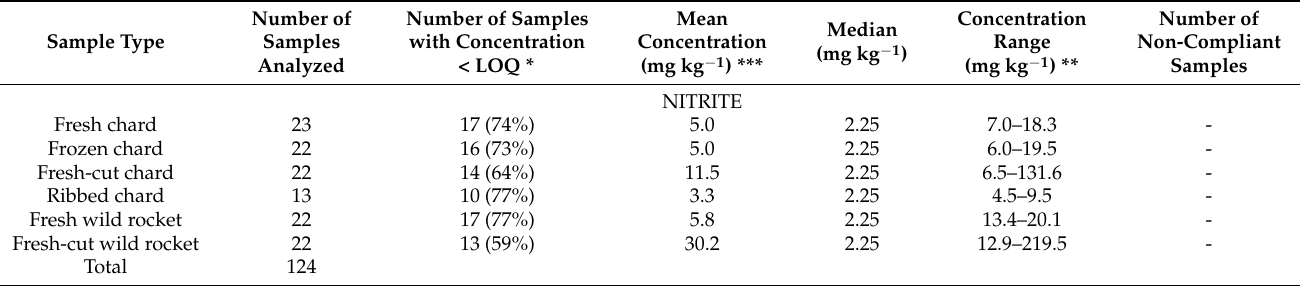
Figure 3. Chromatogram examples of CIC analyses. ( A ): Nitrite and nitrate standard solution; ( B ): Fresh-cut Swiss chard sample with nitrate concentration of 3096.4 mg kg − 1 ; ( C ): Fresh-cut wild rocket sample with nitrate concentration of 6471.5 mg kg − 1 ; ( D ): Fresh-cut Swiss chard sample with nitrite concentration of 145.5 mg kg − 1 ; ( E ): Fresh-cut wild rocket sample with nitrite concentration of 191.4 mg kg − 1 . Table 2. Nitrite and nitrate levels (mg kg − 1 ) and distribution (%) in different leafy vegetables (n =